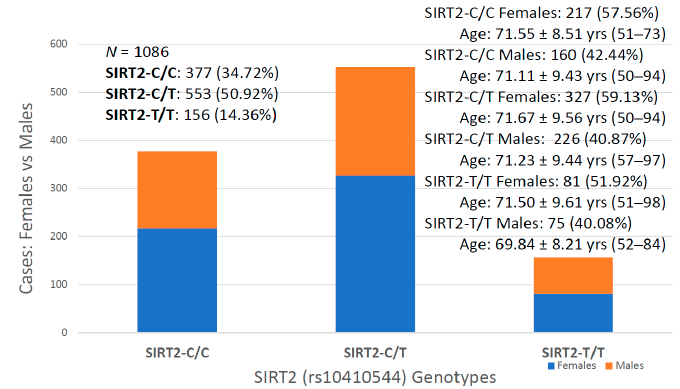
Figure 1. Sex-related differences in the distribution and frequency of SIRT2 (rs10410544) variants in Alzheimer’s disease.